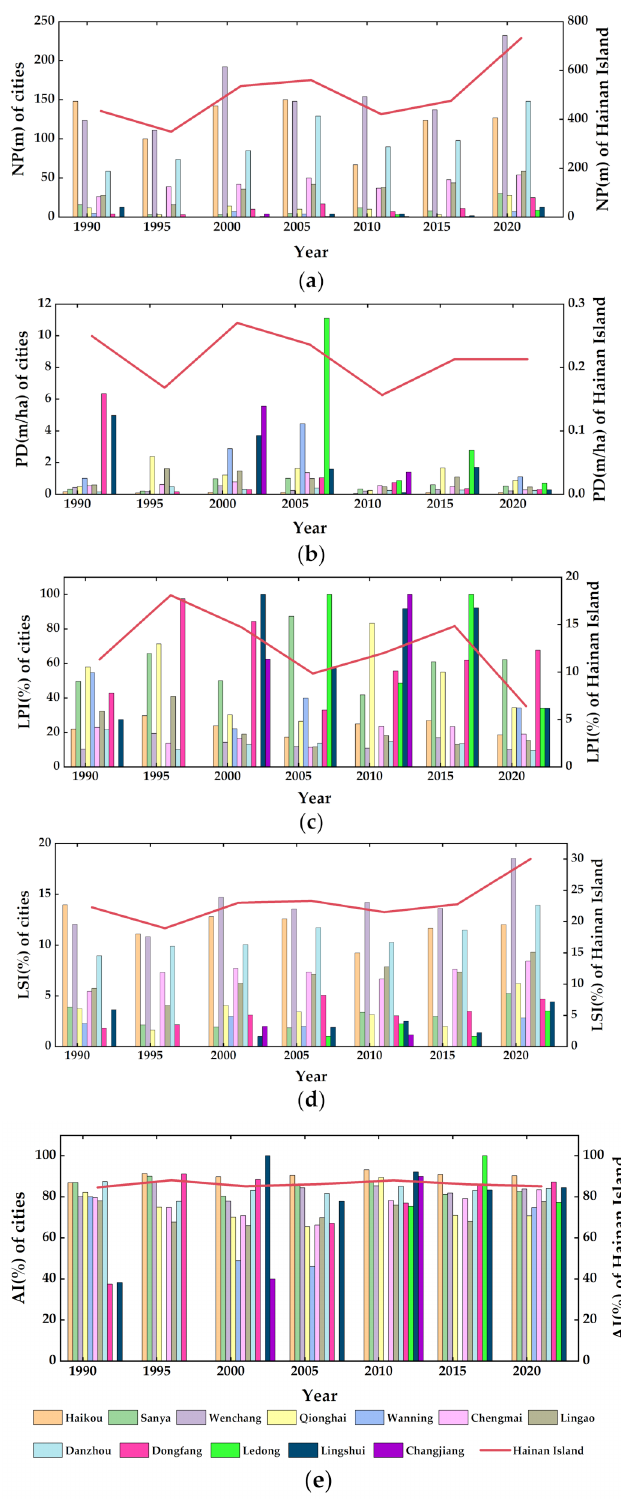
Figure 8. Landscape pattern index of mangrove forests in the Hainan Island during